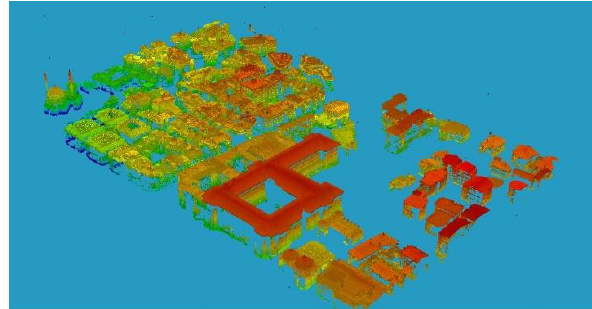
Figure 7. The automated extracted 3D building objects using OBIA